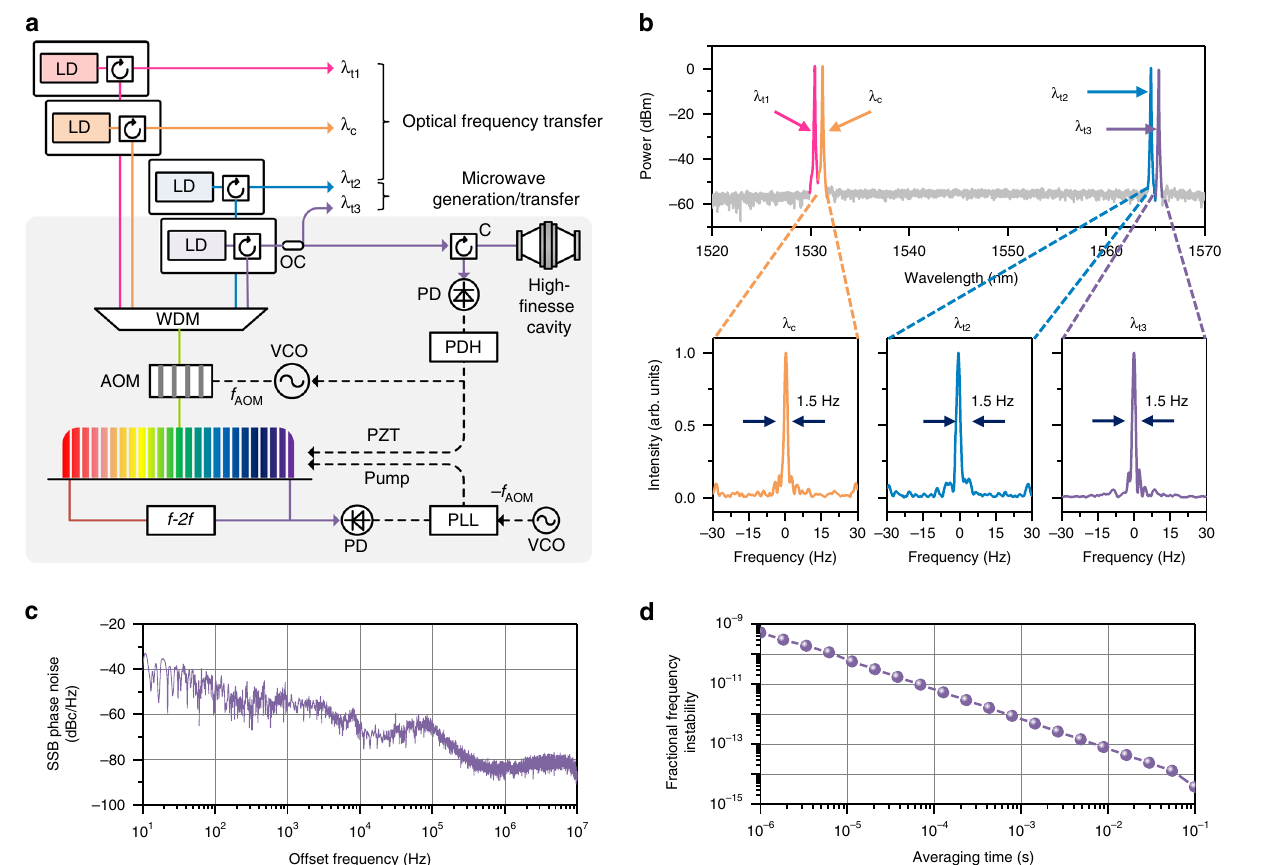
Fig. 2 Comb-rooted optical frequency synthesis a The source comb is stabilized by controlling the repetition rate and the offset frequency. Multiple comb modes are selected out as optical carriers and ampli fi ed by injection locking to laser diodes (LD), while one comb mode is phase-locked directly to a high- fi nesse cavity. PD photodetector, C optical circulator, OC optical coupler, VCO voltage-controlled oscillator, AOM: acousto-optic modulator, PZT: piezo- electric transducer. WDM: wavelength division multiplexer. b Optical and RF beat spectra of the optical carriers selected from 1530.3nm to 1564.4 nm, all showing a 1.5 Hz instrument-limited narrow linewidth. c Single side band (SSB) phase noise spectrum of the source comb after stabilization to the high- fi nesse cavity. d The source comb ’ s Allan deviation that is converted from the SSB phase noise